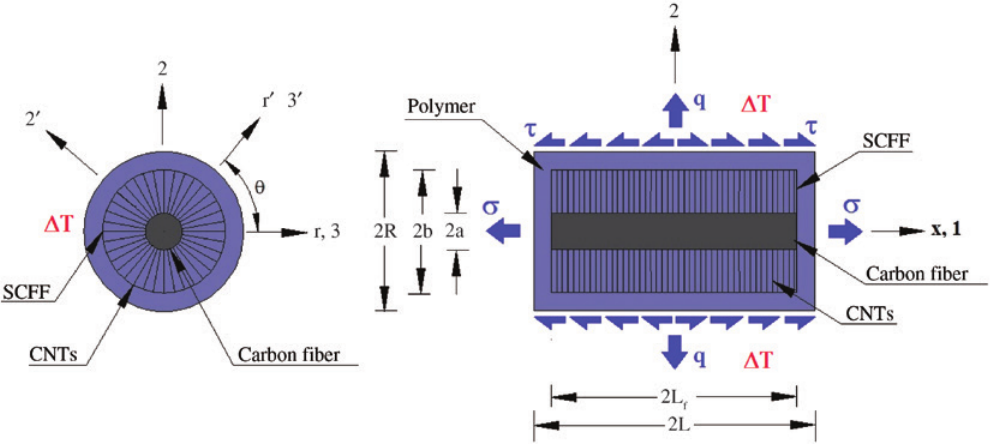
Figure 3: RVE of three-phase